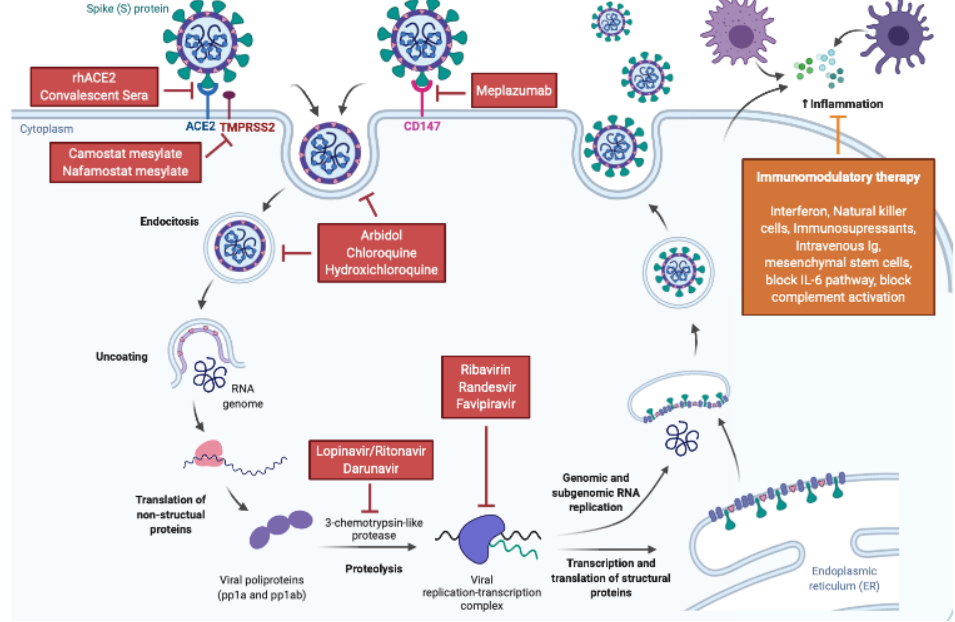
Figure 2. Scheme of the SARS-CoV-2 replication cycle, the host immune response and potential drug targets. This picture shows a simplified SARS-CoV-2 life cycle in the target cells as well as a representation of the immune response against the virus. The targets of antiviral therapies and immunomodulation approaches are highlighted.